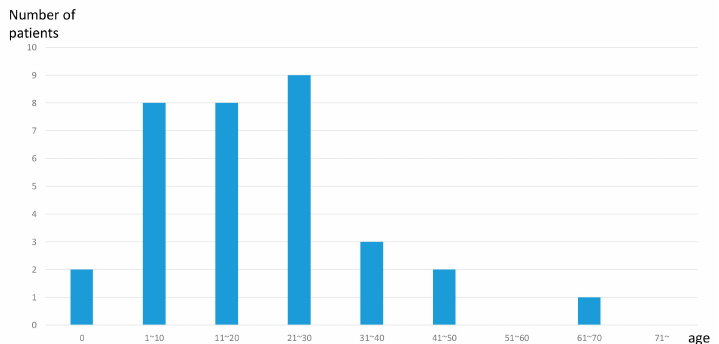
Figure 2. Distribution of the onset age of MYO6 -associated hearing loss cases. Histogram of 33 cases segregated into 10-year intervals or congenital.